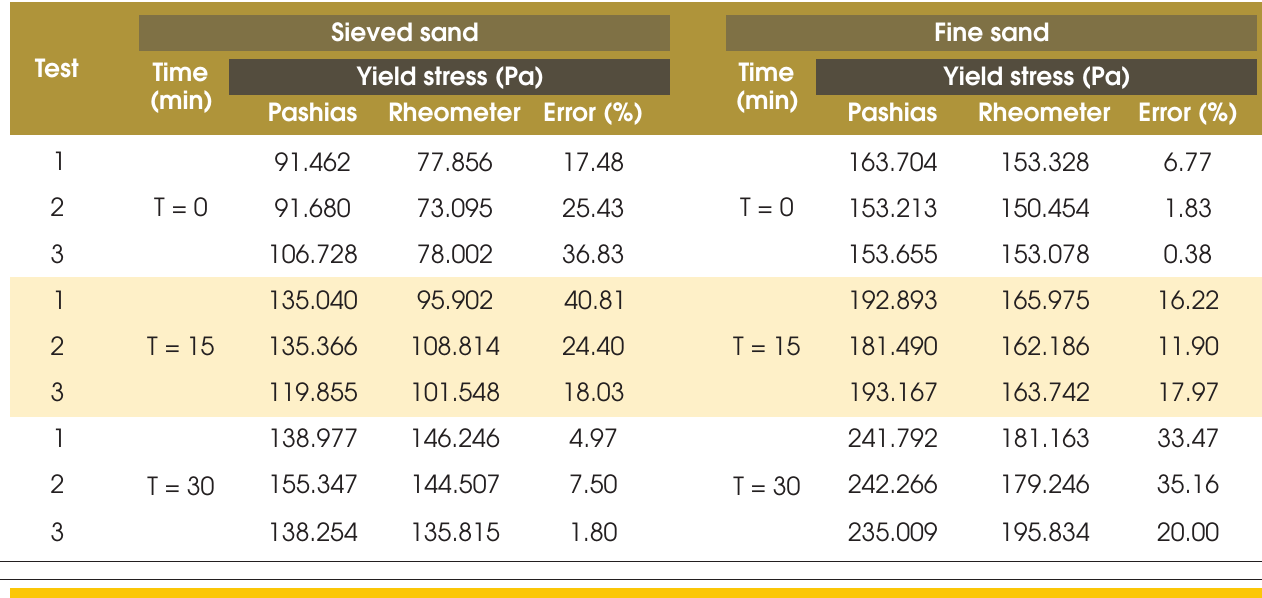
Table 12 – Comparison of yield stress calculated by the method of Pashias and by classical rheometry with their respective errors for mortars with w/c ratio = 0.50